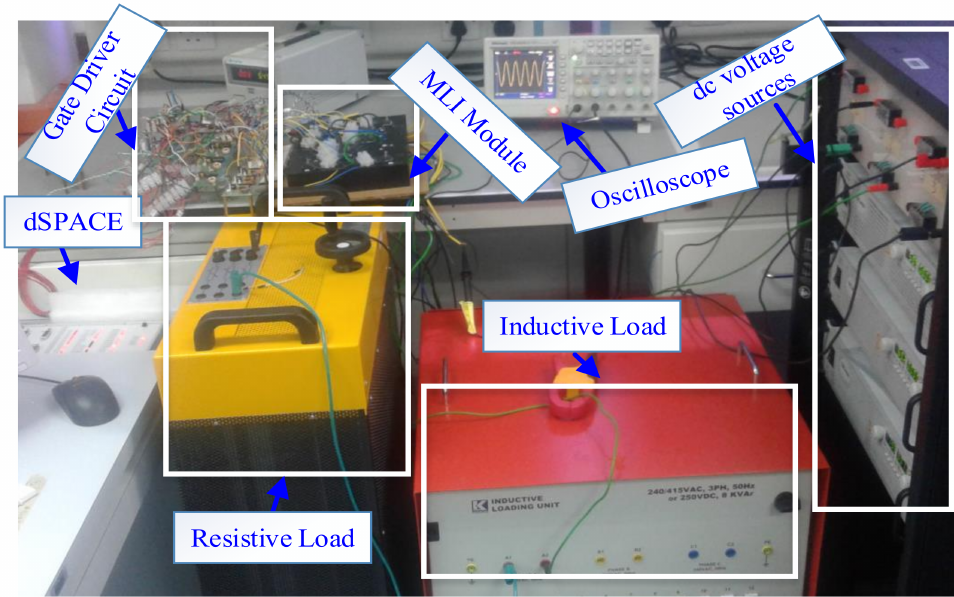
Figure 9. Experimental Prototype.